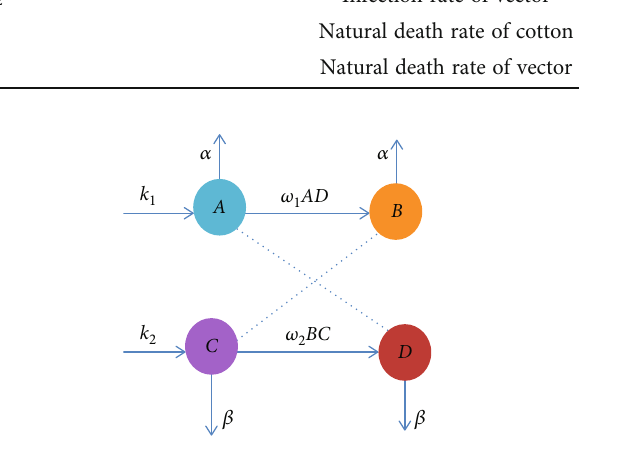
Figure 1: Flow chart of the